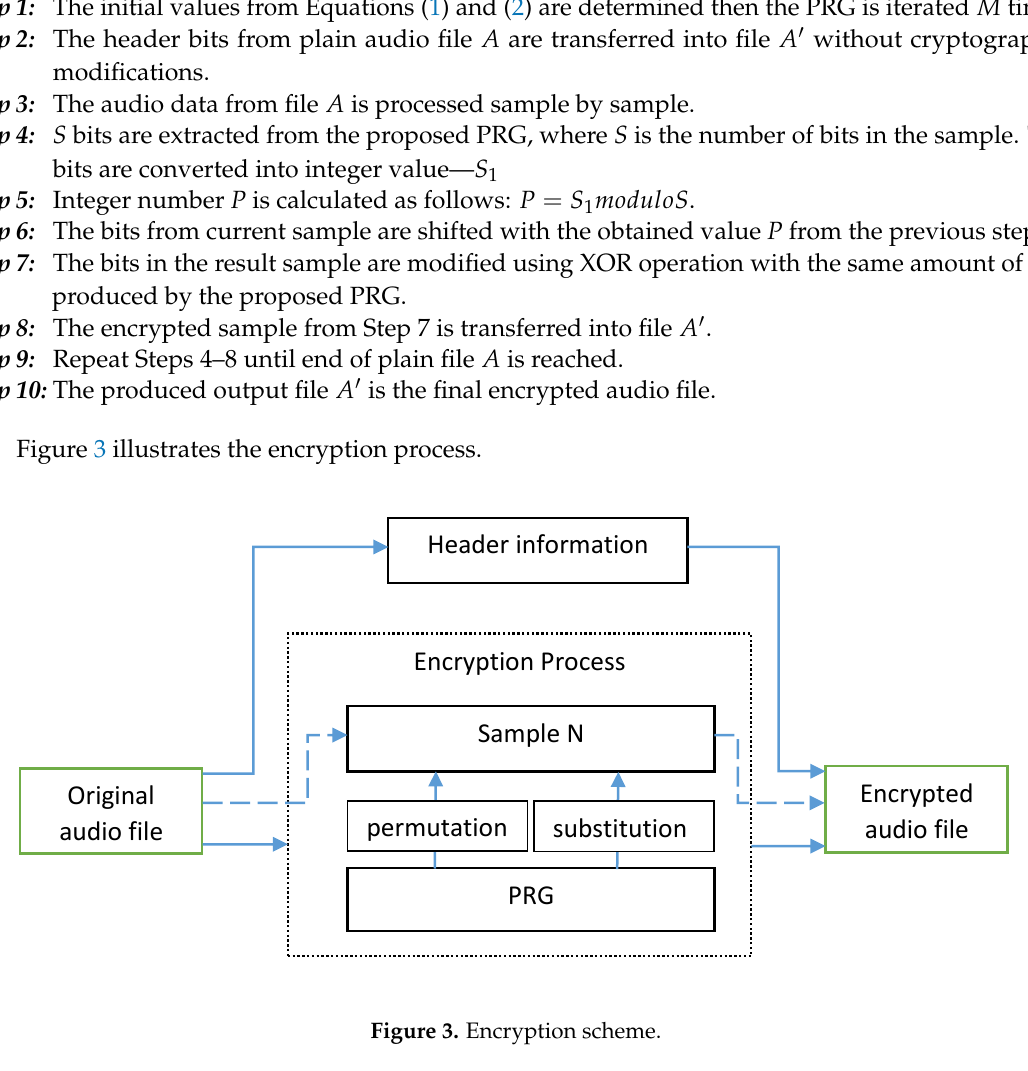
Figure 3. Encryption